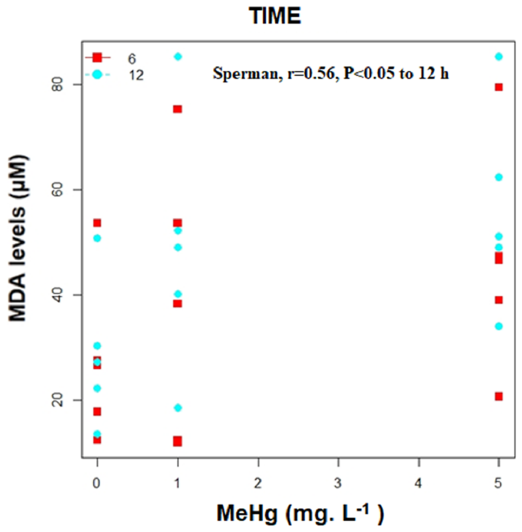
Figure 6. Spearman’s correlation between the variables MeHg concentration, exposure time and MDA levels.